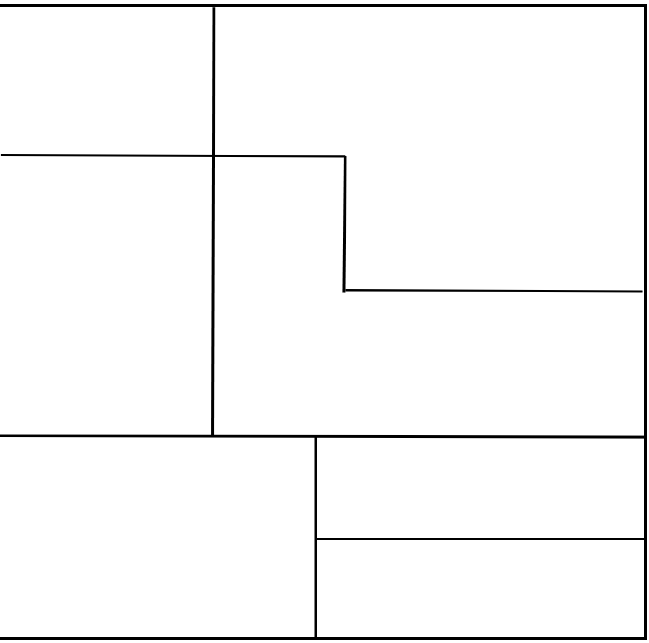
Figure 7. The map with 0.5 × 0.5 km 2 .